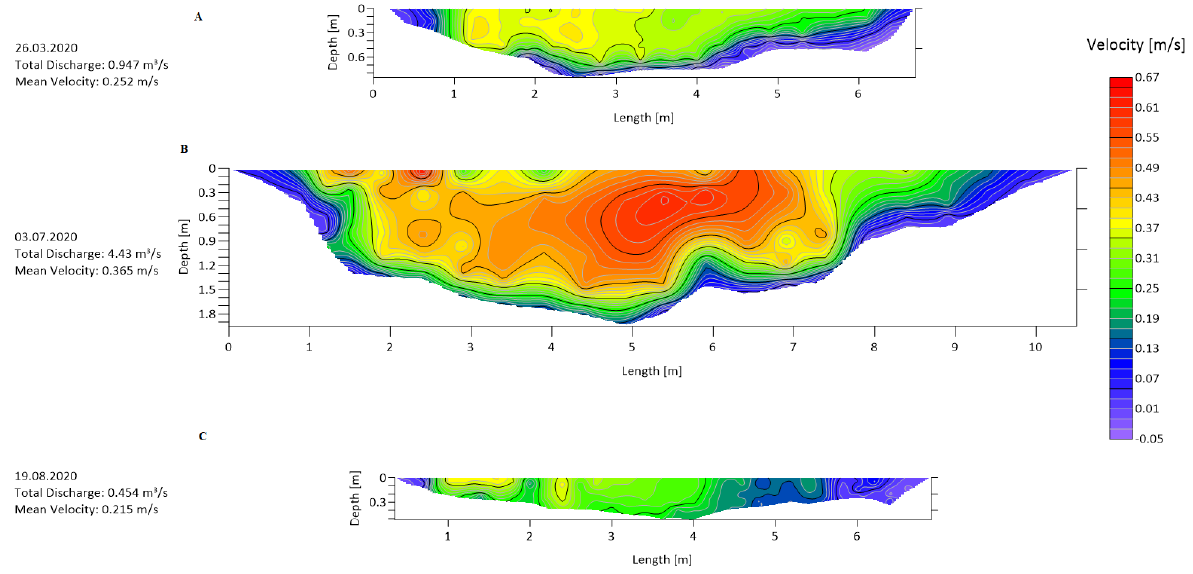
Figure 4. Velocity contour profiles during ( A ) normal flow conditions in March, ( B ) post-flood conditions in July, and ( C ) low-flow conditions in August.